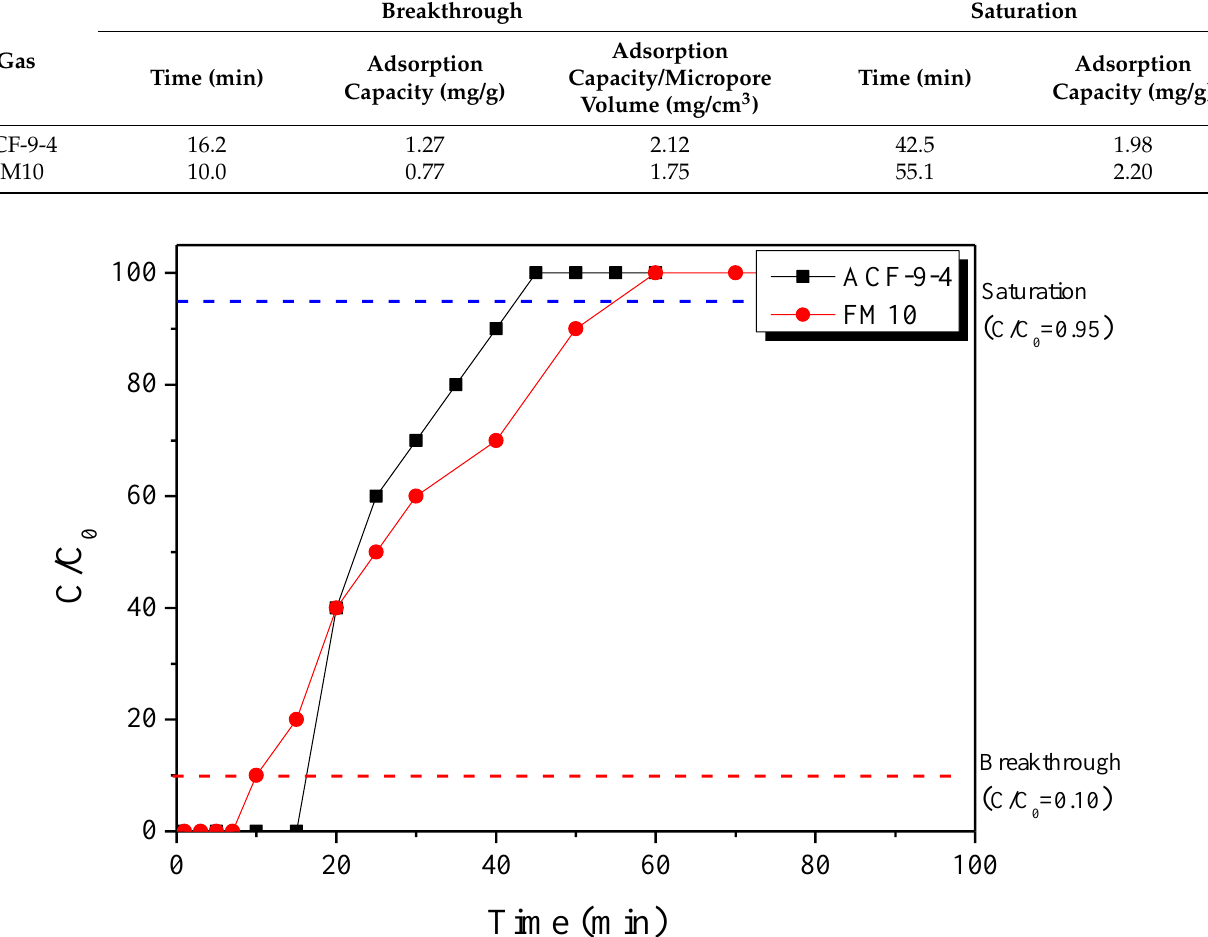
Figure 10. Breakthrough curves for the acetaldehyde adsorption of LLDPE-based activated carbon fibers.